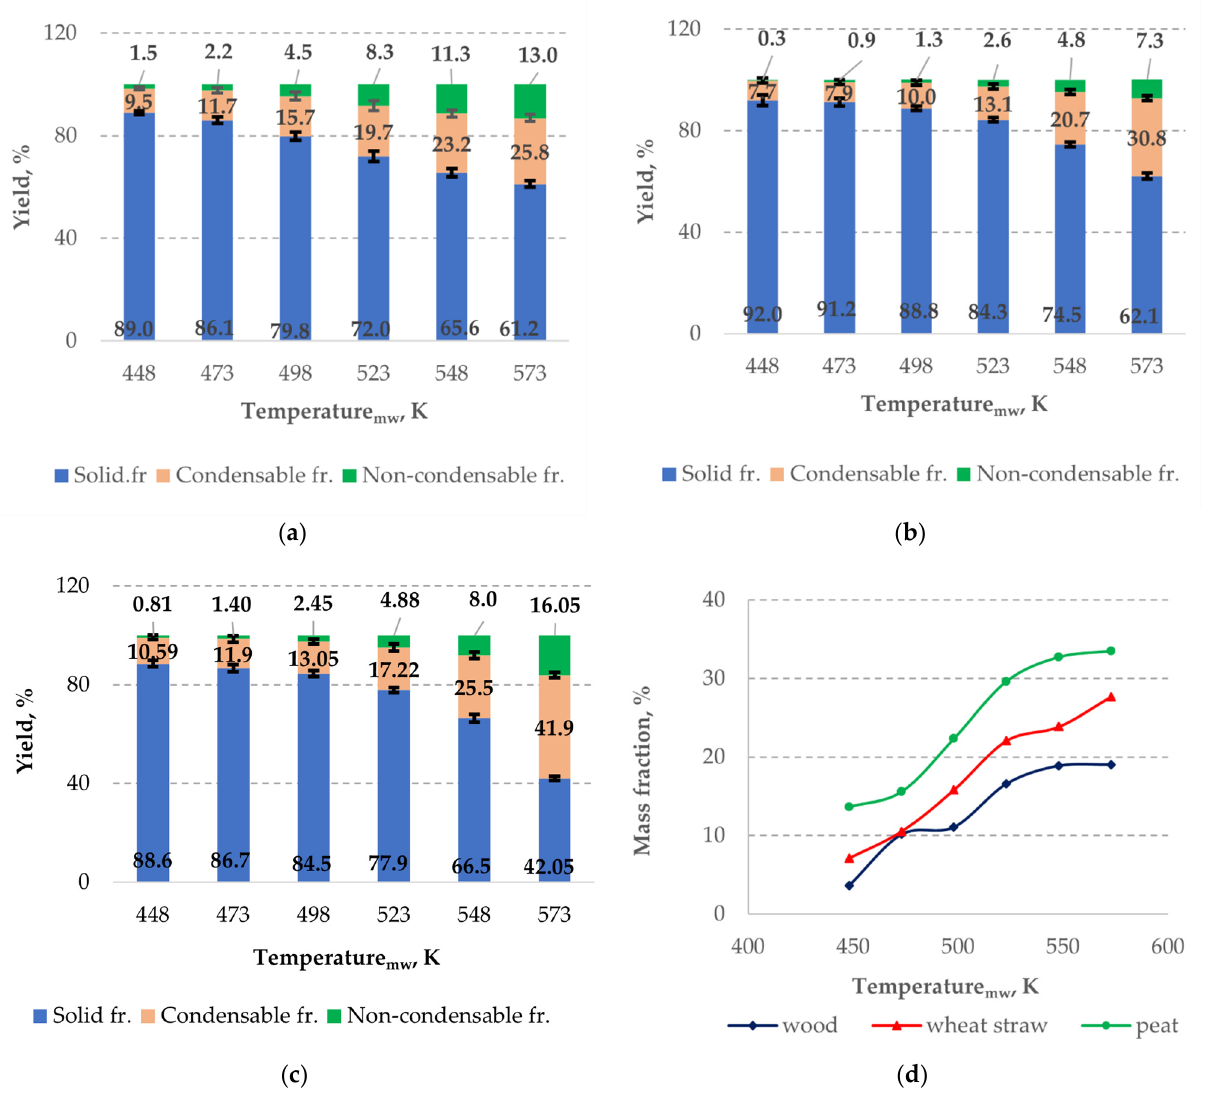
Figure 4. The yields of products (normalized to 100%) of mw-assisted pretreatment of different biomass depending on temperature: wood ( a ), peat ( b ), wheat straw ( c ) and the mass fraction of non-condensable gases in released volatiles ( d ) .